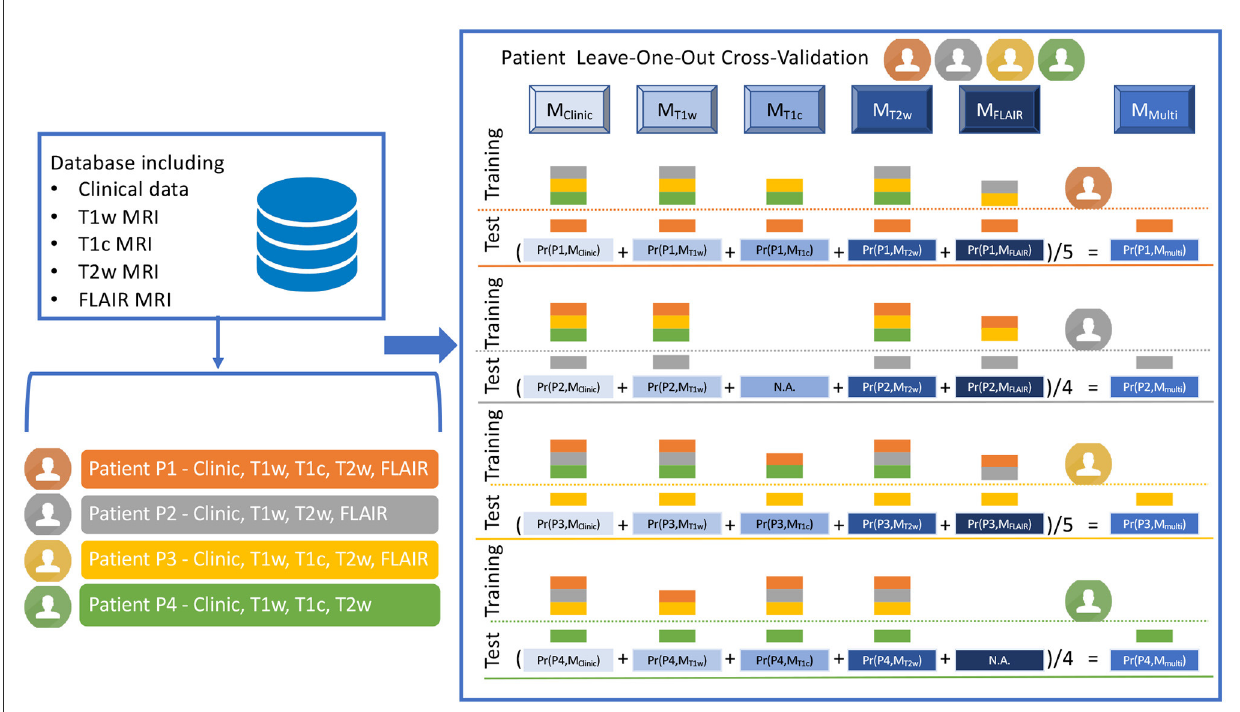
FIGURE3 Illustration of the LOO-CV-MIM framework, i.e. the Leave-One-Out Cross-Validation framework dealing with Missing Imaging Modalities. The LOO-CV-MIM framework is applied to a binary classification task (the prediction of a mutation in our current study). The database given as a fictitious example includes four patients (P1, P2, P3, and P4, displayed in orange, gray, yellow, and green colors), P1 and P3 having the five modalities (clinical data, T1w, T1c, T2w and FLAIR MRI), P2 having one missing modality (T1c), and P4 having also one missing modality (FLAIR). For P1 (resp. P3), five models M j (with j ∈ { Clinic , T 1 w , T 1 c , T 2 w , FLAIR } ), are defined using as training database all the patients except P1 (resp. P3) for which the modality is present (the training database includes three patients for M Clinic , M T 1 w , and M T 2 w , and two patients for M T 1 c and M FLAIR ). These five models are then tested onto the remaining patient P1 (resp. P3), providing five probabilities of mutation Pr ( P 1, M j ), with 0 ≤ Pr ( P 1, M j ) ≤ 1 (resp. Pr ( P 3, M j )) and thus five predictions of mutation. A sixth prediction of mutation corresponding to M Multi , is defined as the mean value of the five probabilities Pr ( P 1, M j ) (resp. Pr ( P 3, M j )). For patients P2 (resp. P4) having one missing modality, a similar process is applied but only four (and not five) models M j are defined (there is no model M T 1 c for P2, no model M FLAIR for P4), providing four probabilities Pr ( P 2, M j ) (resp. Pr ( P 4, M j )). A fifth prediction of